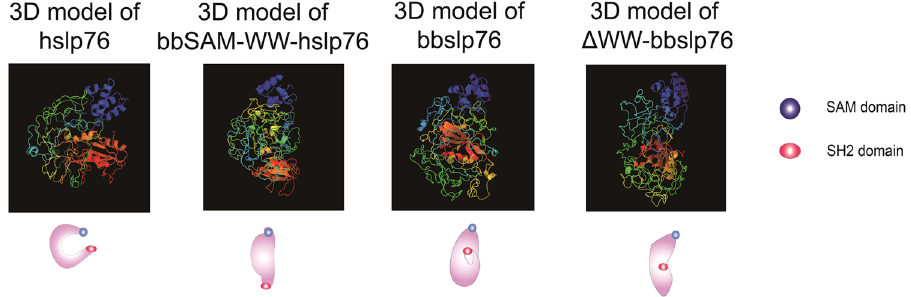
Figure 7. 3D model comparison of hslp76, bbSAM-WW-hslp76, bbslp76 and Δ WW-bbslp76. The 3D structures were predicted by